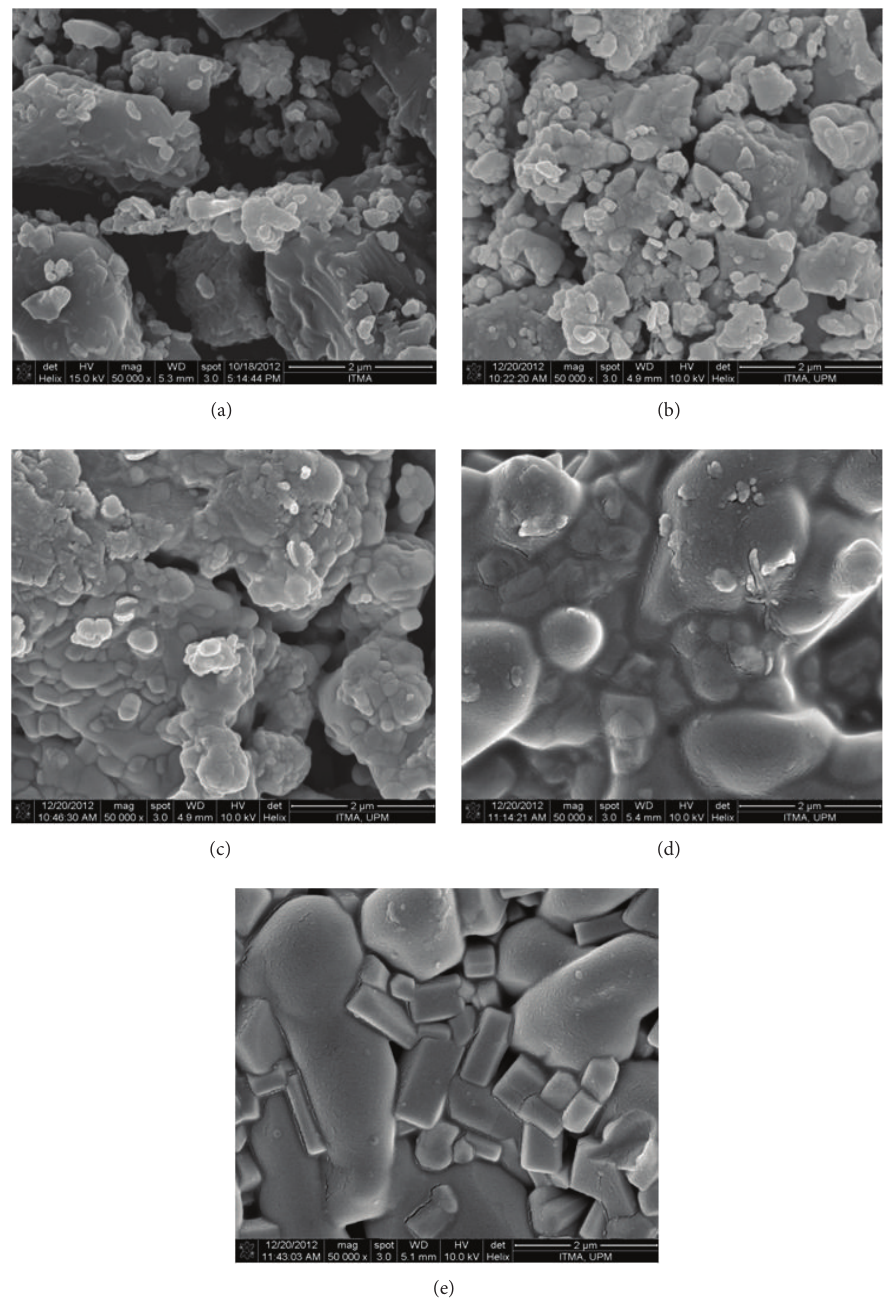
Figure 7: FE-SEM micrographs of 3wt% Eu 2 O 3 doped willemite samples sintered at (a) 600 ∘ C, (b) 700 ∘ C, (c) 800 ∘ C, (d) 900 ∘ C, and (e) 1000 ∘ C for